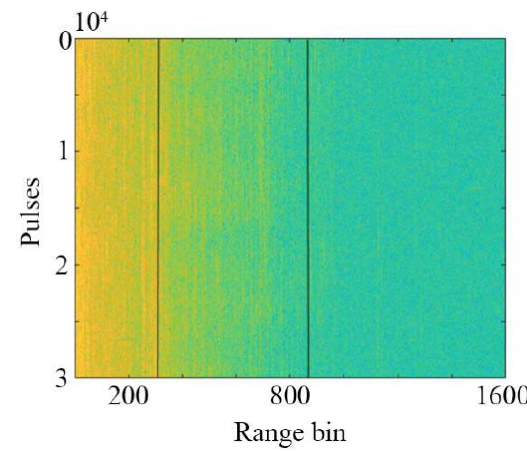
Figure 6. Sea-surface-zoning results with T = 0.5.